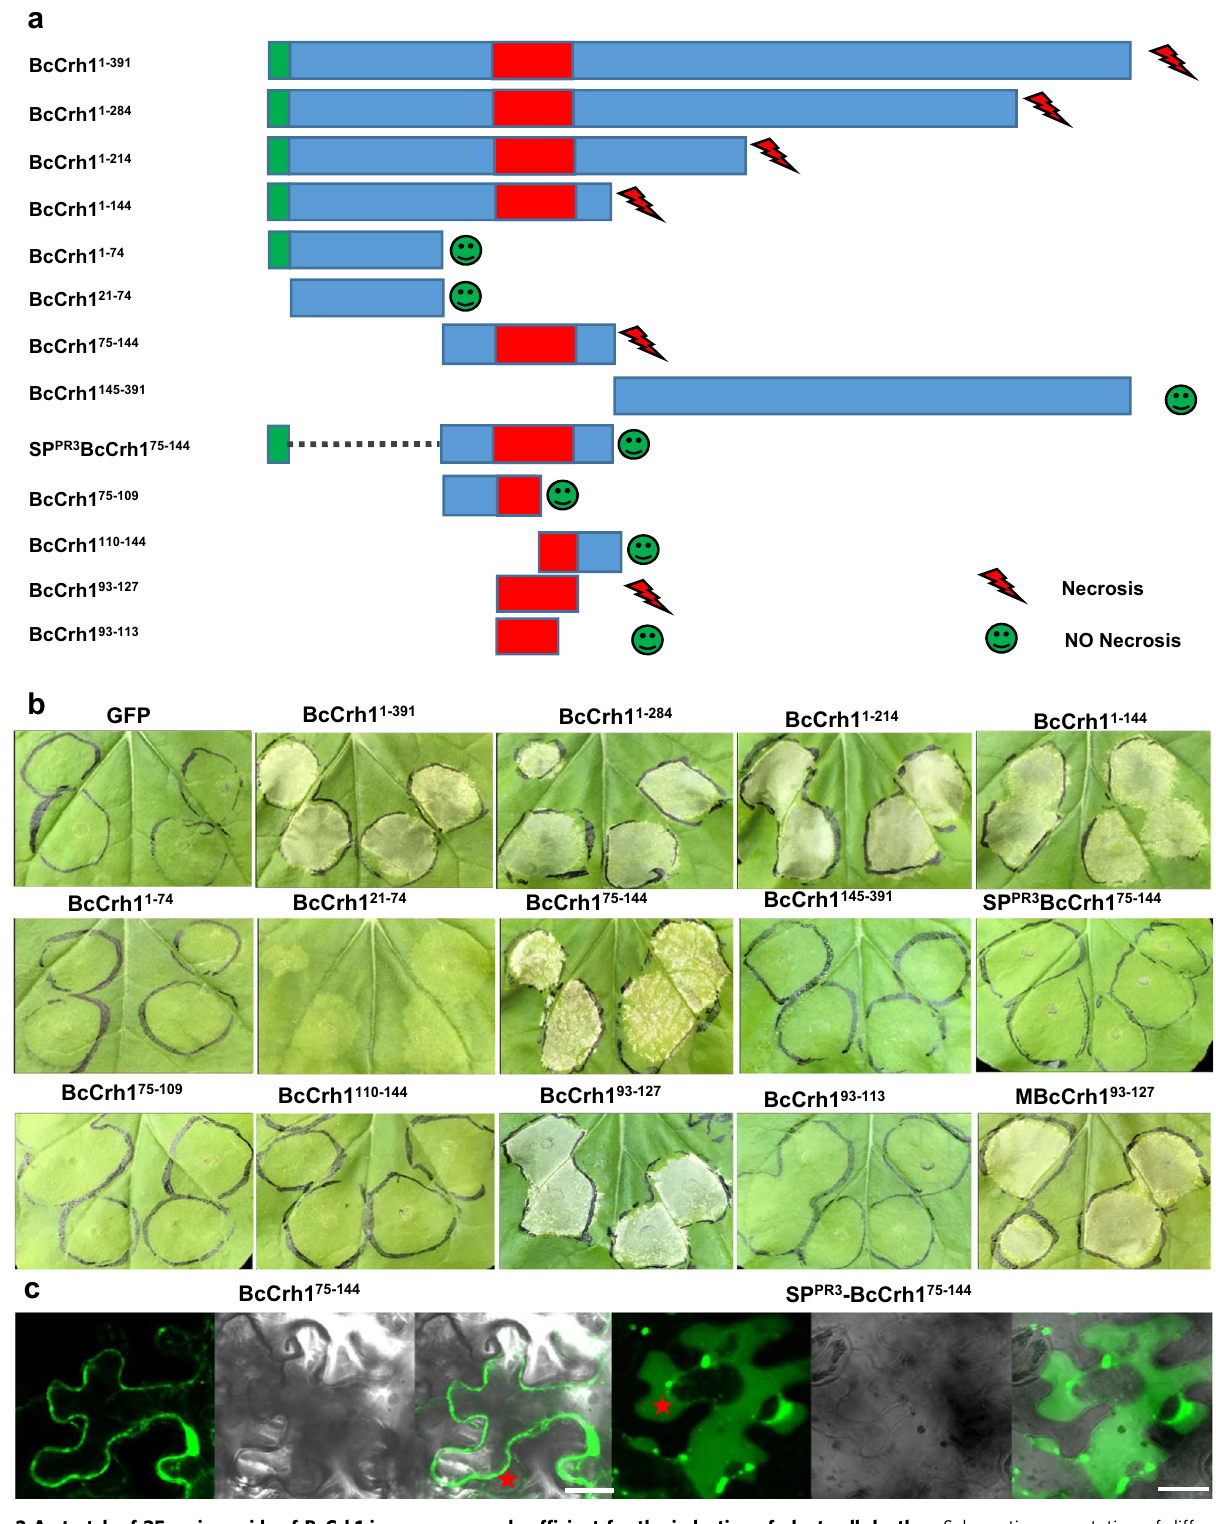
Fig. 2 A stretch of 35 amino acids of BcCrh1 is necessary and suf fi cient for the induction of plant cell death. a Schematic presentation of different BcCrh1 fragments that were used in Agroin fi ltration assays. Green — SP, Red — the minimal region that was found to be suf fi cient for induction of cell death, Blue — other regions of the tested fragment. b – c representative images of leaves following in fi ltrations with Agrobacterium strains that contain constructs encoding the different BcCrh1 fragments. b Pictures were taken fi ve days after Agroin fi ltration; c Leaves were harvested two days after Agroin fi ltration, submerged for 20 min in 0.8 M mannitol to induce plasmolysis, and then samples were scanned by a confocal microscope. Typical apoplastic space between the cell wall and plasma membrane in plasmolysed plant cells is marked with red asterisks. Bars = 20 μ m. All the above experiments were repeated at least three times with similar